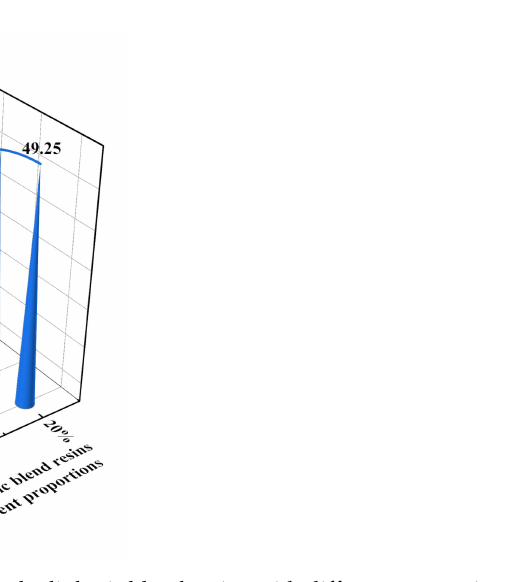
Figure 4. Breakdown field strength of cycloaliphatic blend resins with different proportions during salt aging.